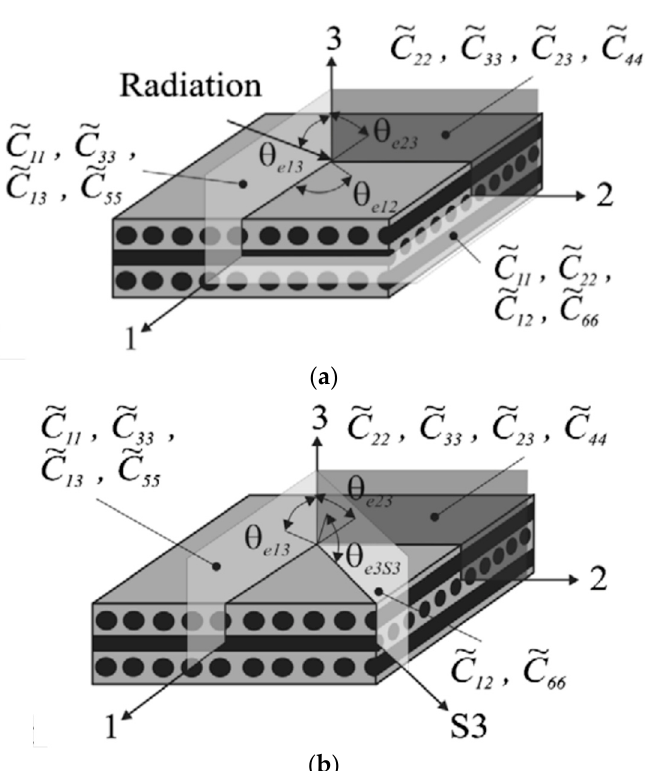
Figure 1. Determination of stiffness matrix coefficients by measurement in ( a ) symmetry planes and ( b ) non-symmetry planes [26].